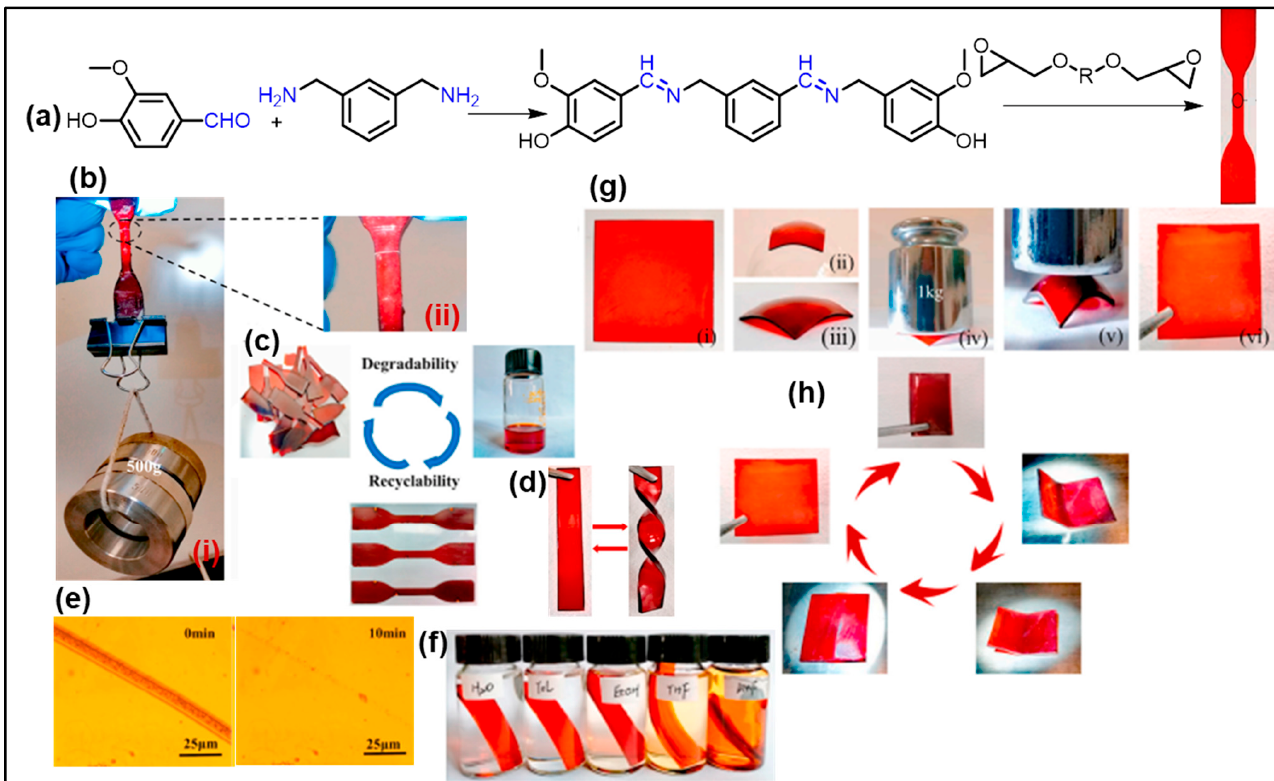
Figure 14. ( a ) Synthesis of vanillin-derived epoxy vitrimer; ( b ) weldability: (i) the specimen suc- cessfully adopted a 500 g load after welding, and (ii) partial magnification of the welding; chemical recyclability ( c ), malleability ( d ), repairability ( e ), solvents resistivity ( f ), hot-driven malleability ( g ): (i) cured vitrimer sheet; (ii) put the sheet on a round bottom flask and heat it at 120 ◦ C for 10 min; (iii) curved sheet in the cooled condition; (iv) remodelled specimen loaded 1 kg except remarkable deflection; (v) 1 kg loaded magnified image of the specimen; (vi) flat shape from the curved specimen after being heated; and ( h ) shape-memorability of the cured vanillin-derived vitrimer [reproduced with permission from Liu et al.; published by Elsevier, 2020] [11].